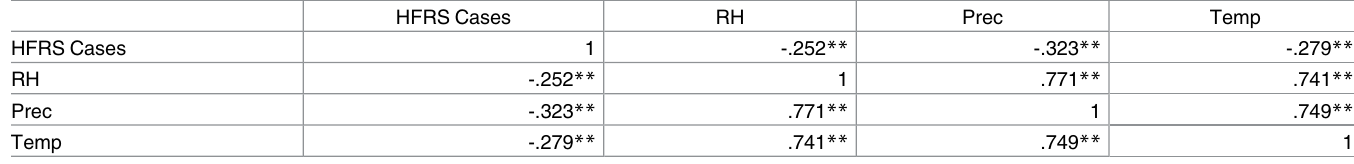
Table 1. Spearman Correlation coefficients of the association between HFRS cases and meteorological